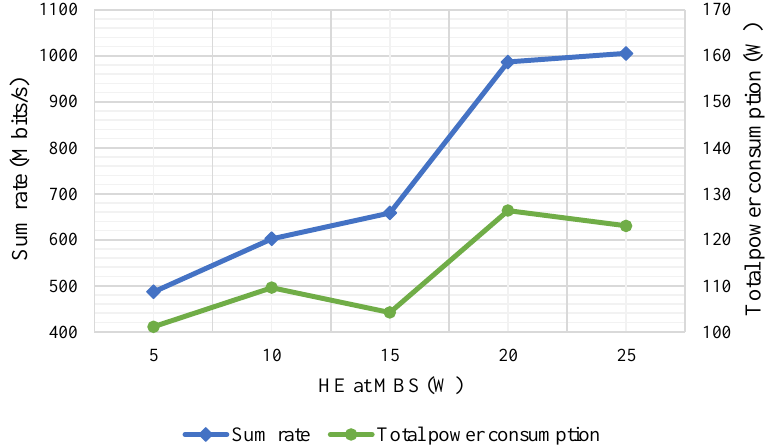
Figure 11. Sum rate and total power consumption for various MBS HE with UEs/cell = 5 and all SBSs are in off